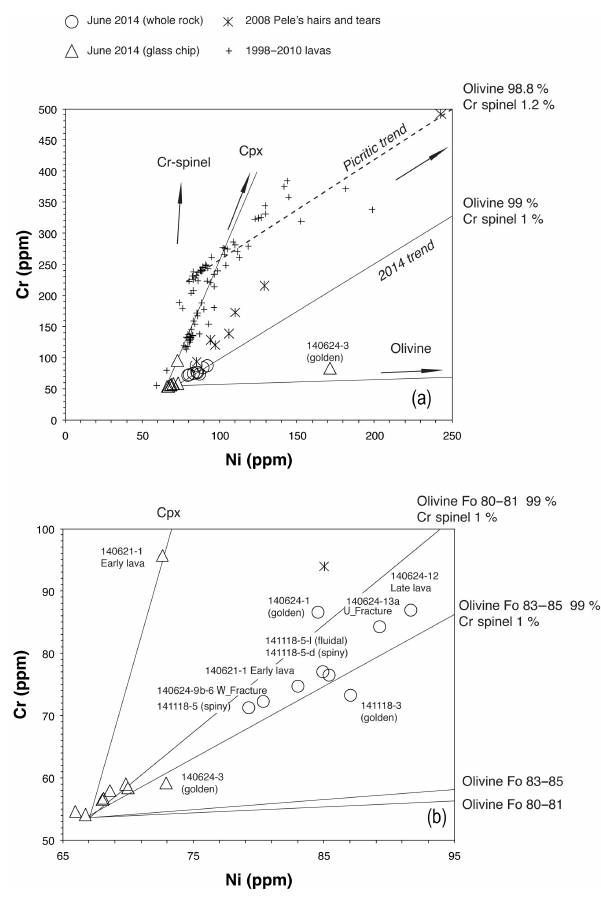
Figure 7. Ni-Cr concentration plot. (a) Ni-Cr signature of the June 2014 lavas compared to that of recent eruptions (Di Muro et al., 2015, and unpublished data). Whole-rock (circles) and glass (triangles) compositions are shown for the June 2014 eruption. Olivine controlled lines are indicated for olivine hosting 1.2 and 0.6wt% Cr spinel. Compositions used for olivine (Ni = 1900ppm, Cr = 300ppm), clinopyroxene (Ni = 970ppm, Cr = 4800ppm), and Cr spinel (Ni = 1500ppm, Cr = 25%) are inferred from Welsch et al. (2009), Salaün et al. (2010), and Di Muro et al. (2015). (b) En- largement of the Ni-Cr relationship between glass (triangles) and whole-rock (circles) samples from the June 2014 eruption. Fracture I: western fracture; Fracture II: upper fracture. Careful sample se- lection has permitted us to obtain a set of fragments virtually free of olivine-cpx crystals. Any addition of mafic crystals translates into enrichment in Ni-Cr; those samples that contain a few percent of crystals (consistent with textural and petrological observation) are slightly enriched in compatible